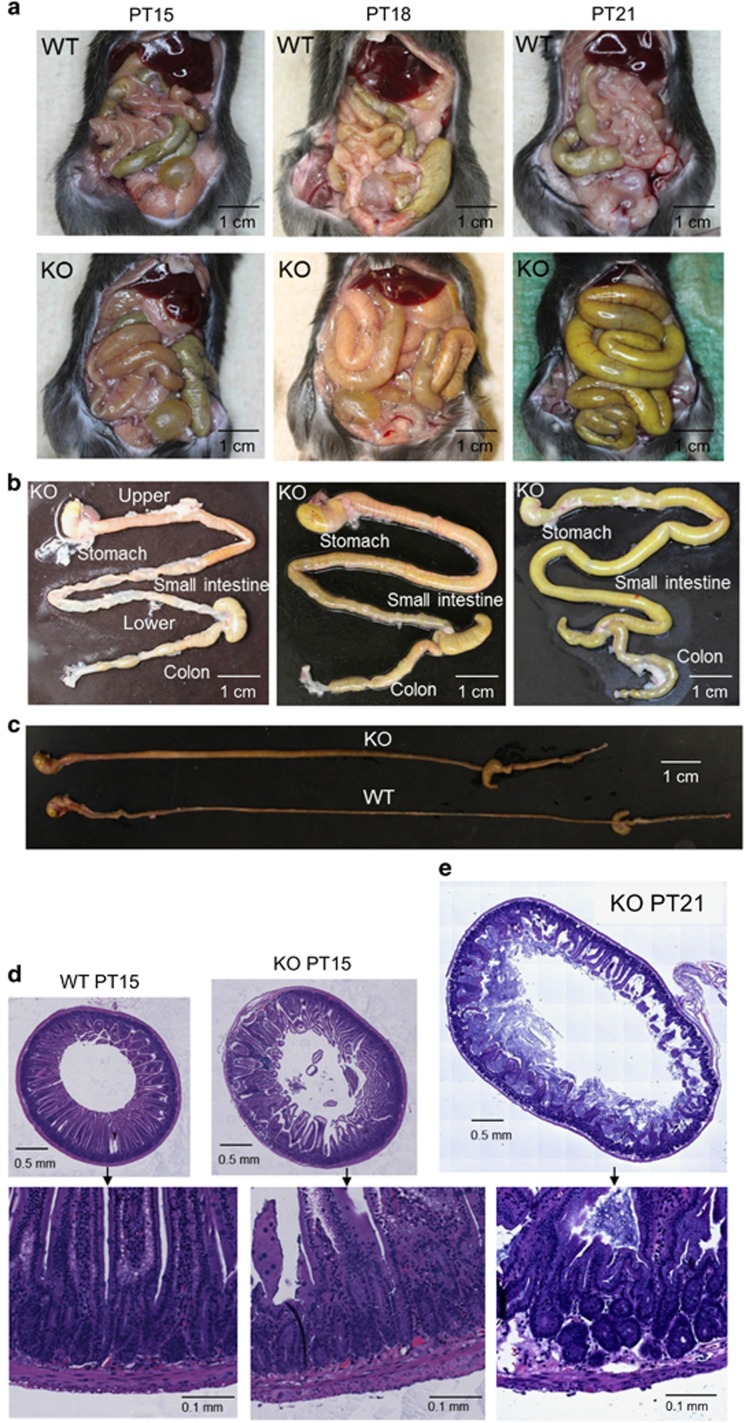
Smooth muscle defect of the inducible SMC-specific Srf KO in GI track. (a) Gross changes of GI tract between WT and KO at 15, 18 and 21 days post-tamoxifen injection (PT15, PT18 and PT21). (b) Morphological changes of Srf KO GI tract showing dilation of upper duodenum at PT15 progressing to lower GI tract at PT18–PT21. (c) Comparison of GI length between WT and KO. (d) Cross-sectional images of WT and KO jejunum with H&E staining at PT15. (e) Cross-sectional images of KO jejunum with H&E staining at PT21